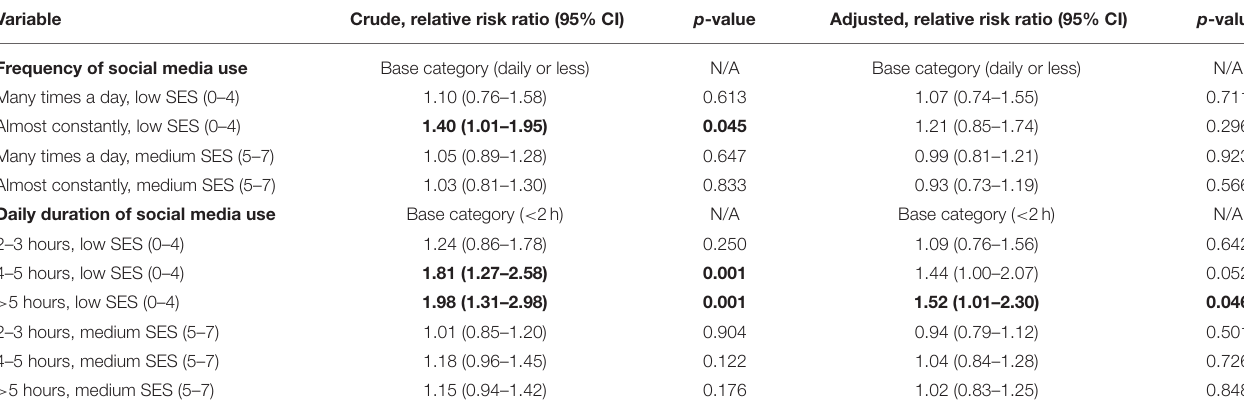
TABLE 2 | Results from multinomial logistic regression for frequency and daily duration of social media use.